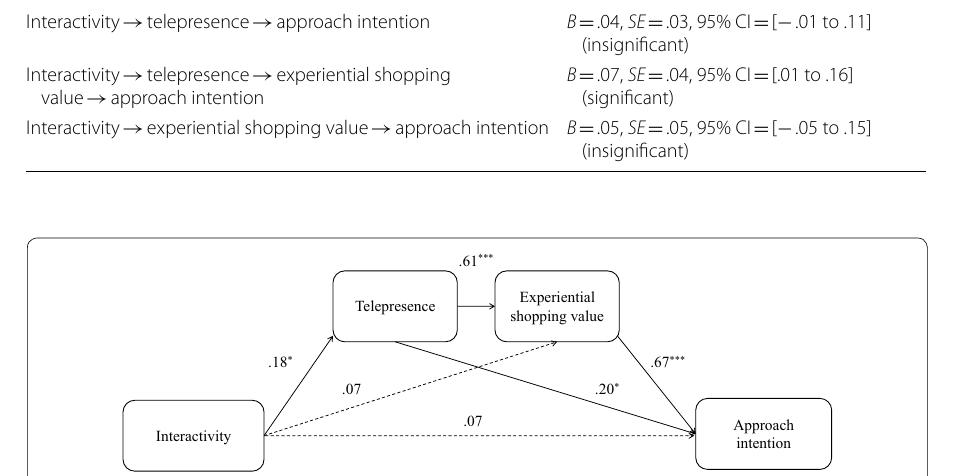
Fig. 4 The sequential mediation model for the effect of interactivity on approach intention. * p < .05, *** p <